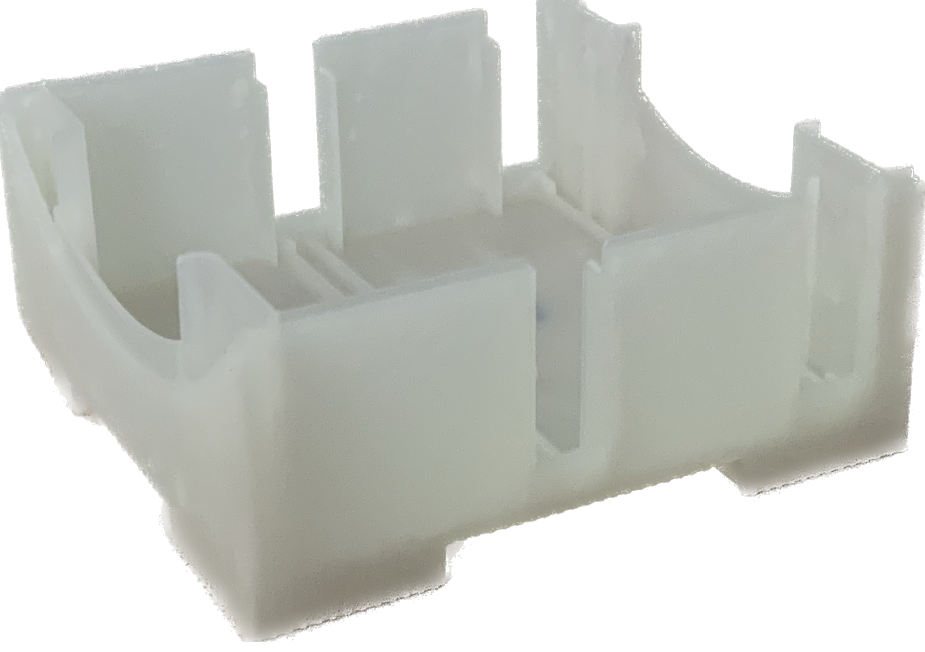
Figure 1. Housing